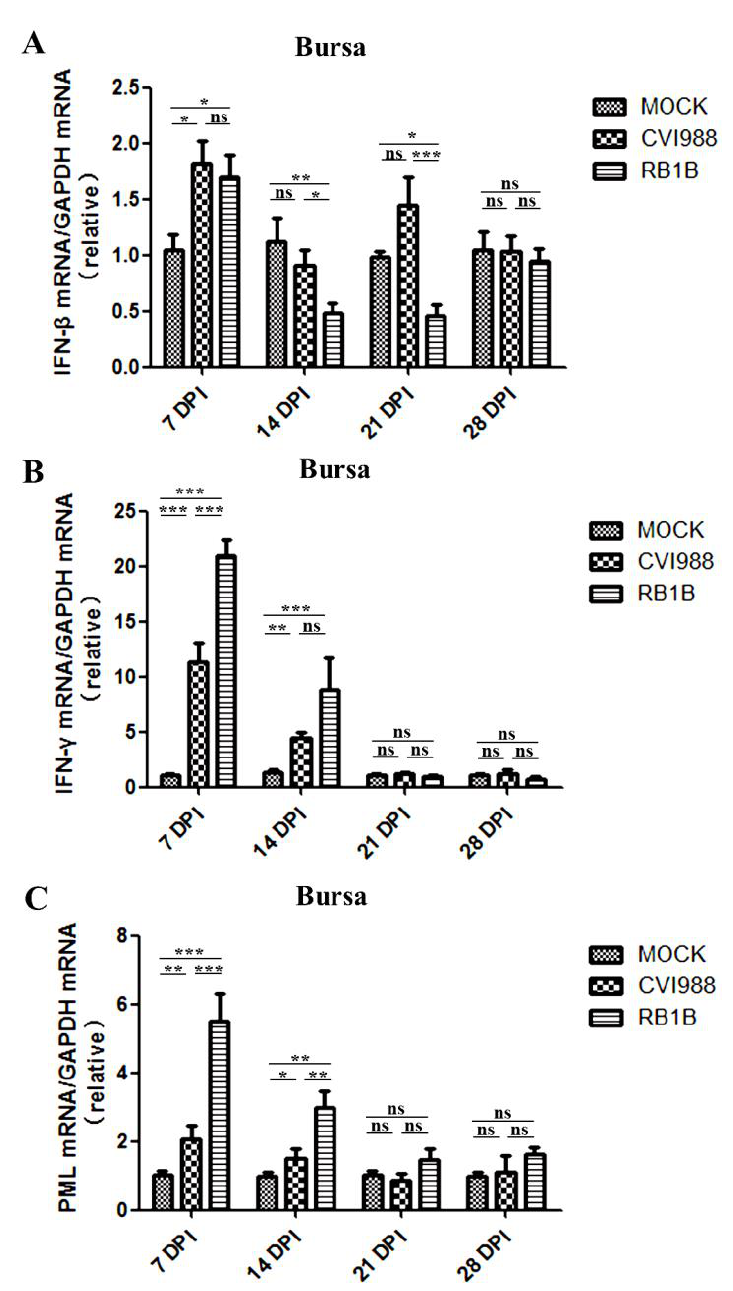
Figure 3. IFN- β , IFN- γ , and PML transcripts in the bursa inoculated with MDV/CVI988 and MDV/RB1B. ( A ): Specific IFN- β transcripts in the bursa; ( B) : specific IFN- γ transcripts in the bursa; ( C ): specific PML transcripts in the bursa. The statistical results are shown as the means ± SD of each experimental group. Statistical significance between each two experimental groups (CVI988 vs. MOCK, RB1B vs. MOCK, CVI988 vs. RB1B) was assessed by t -test (* p < 0.05; ** p < 0.01; *** p < 0.001; ns, no significance).